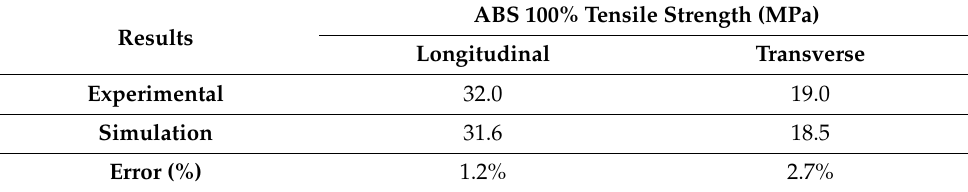
Table 2. Outcomes using the reverse engineering method.